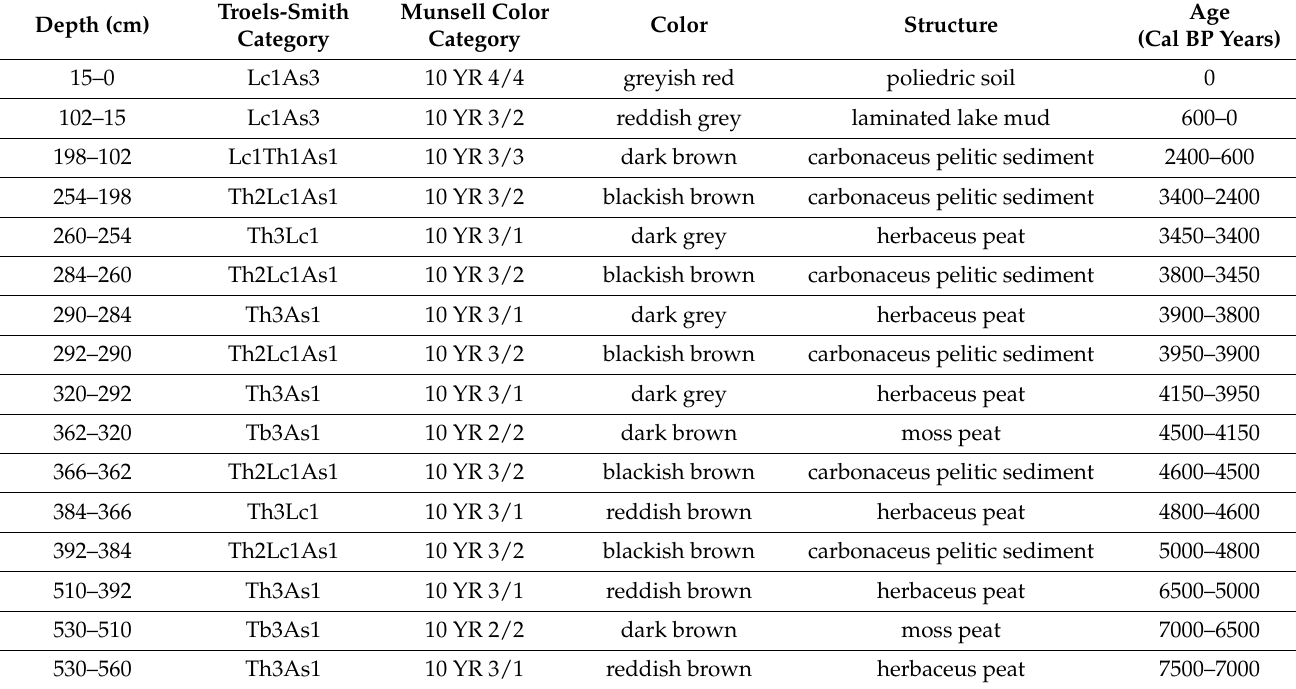
Table 1. Sediment layers and their description from the undisturbed core sequence of Round Lake. Th: Turfa herbacea Tb:turfa bryophitica Lc: Limus calcareus As: Agrilla steatodes (Troels-Smith scheme available on https://pg-du.org/troels- smith-scheme/ (accessed on 19 April